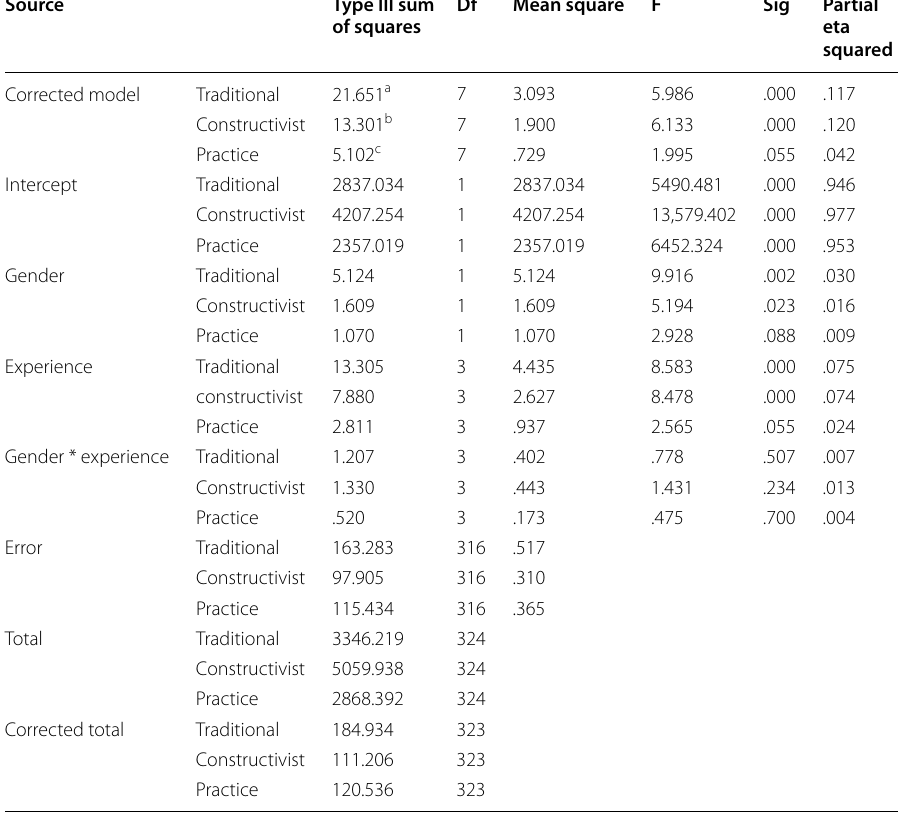
a R Squared b R